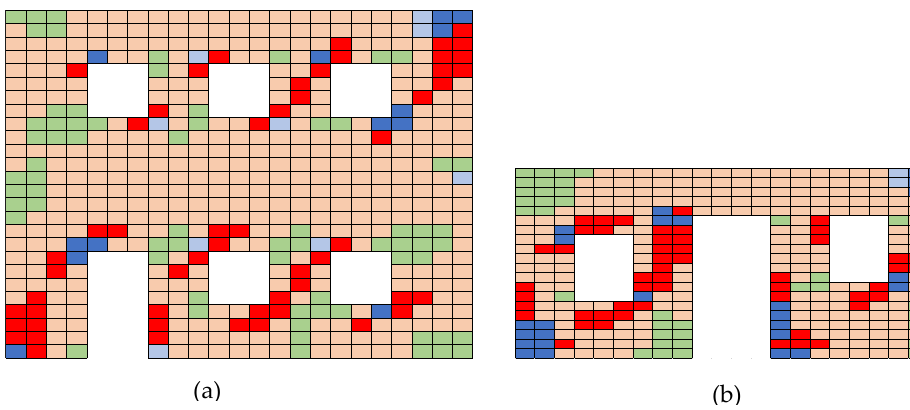
Figure 9. Stress states at ultimate conditions for the wall specimens by ( a ) Moon et al. [31] (left), ( b ) Nagethi and Alemi [32] (right). For colors, refer to Figure 7.